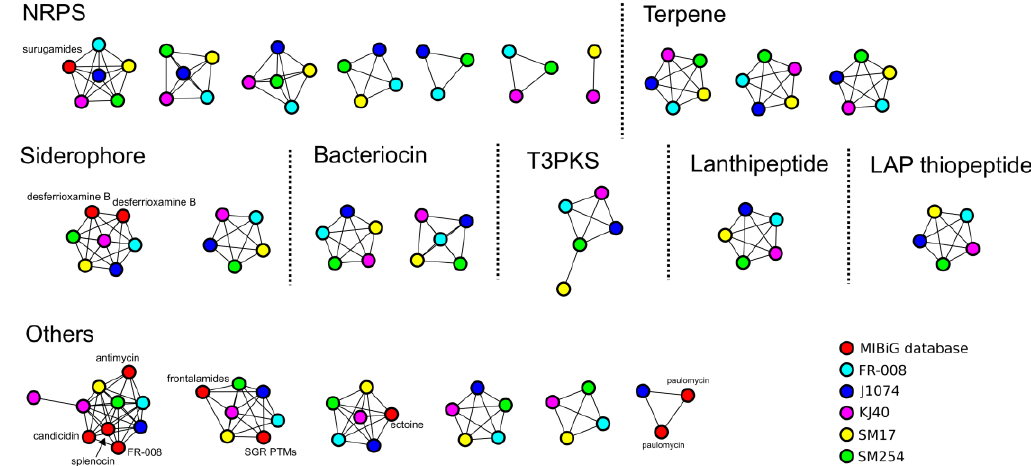
Figure 3. Biosynthetic gene clusters (BGCs) similarity clustering using BiG-SCAPE. Singletons, i.e., BGCs without significant similarity with the BGCs from the minimum information about a biosynthetic gene cluster (MiBIG) database or with the BGCs predicted in other genomes, are not represented.